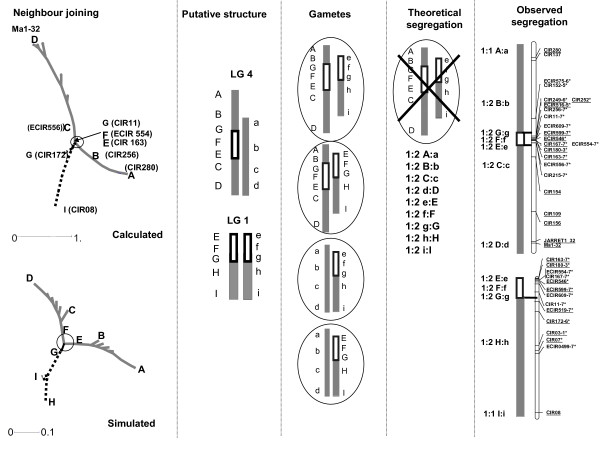
Putative rearrangement event between PLG 4 and PLG 1 in P. Lilin. The observed segregations are given along the linkage groups. Loci labeled with asterisks showed distorted segregation (1* P < 0.05, 2* P < 0.01, 3* P < 0.005, 4* P < 0.001, 5* P < 0.0005, 6* P < 0.0001, 7* P < 0.00005). Main gametes do not take into account the different allelic combination generated by recombination between homologous segments. Underlined loci are anchor markers. The solid grey line corresponds to PLG 4 and the dotted lines to PLG 1. In SSR names, mMaCIR has been abbreviated to CIR, and mMECIR to ECIR.